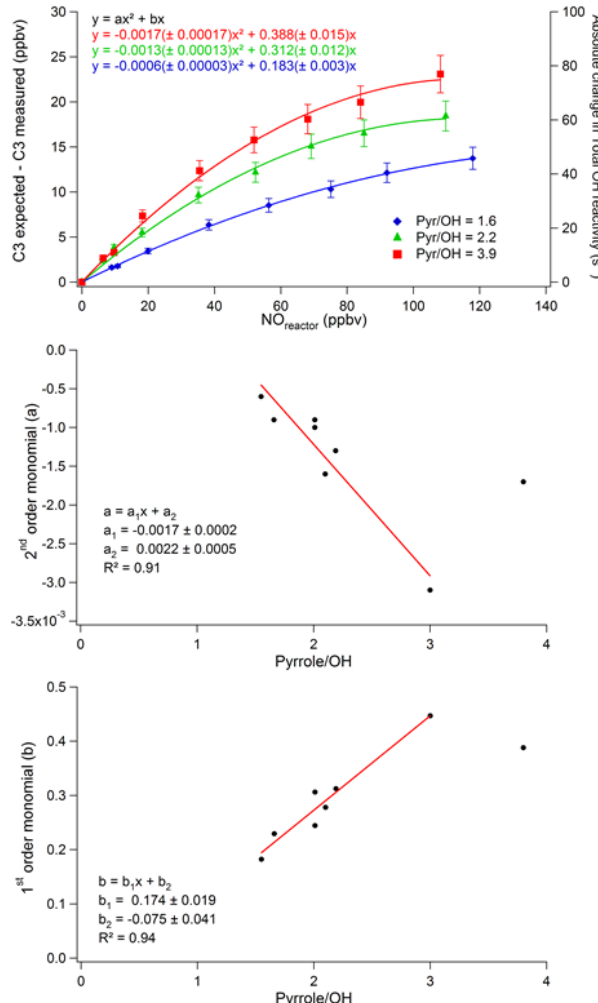
Figure 3. Experimental parameterization of the NO artifact. Top panel left axis: changes in C3 ( (cid:49) C3 = C3 expected − C3 measured) as a function of NO in the CRM reactor. Three experiments con- ducted at pyrrole-to-OH ratios of 1.6 (blue diamonds), 2.2 (green triangles), and 3.9 (red squares) are shown. The right axis corre- sponds to absolute changes in total OH reactivity for the experiment conducted at a pyrrole-to-OH ratio of 2.2. Solid lines are quadratic regressions, whose equations are shown. Error bars are uncertainties in (cid:49) C3 (approximately 9%) calculated by a quadratic propagation of errors. Middle and bottom panels: trends of the first- (bottom) and second-order (middle) monomials with the pyrrole-to-OH ratio for the quadratic regressions displayed in the top panel. The exper- iment performed using dry zero air (pyrrole-to-OH ratio of 3.9) is not included in the linear regressions (see